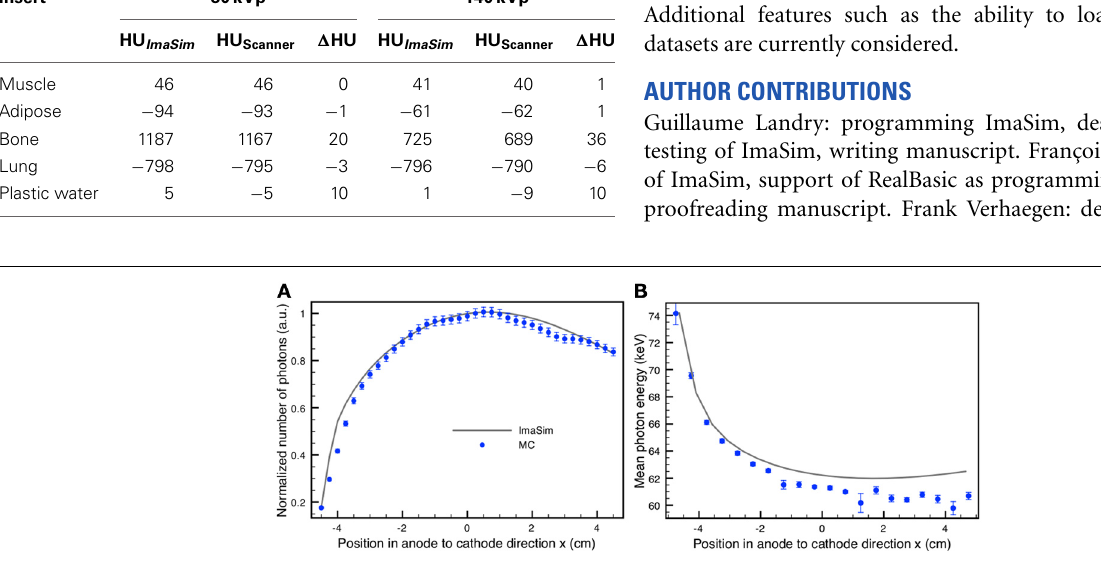
Table 2 | Comparison of HU from simulation and measurement. HU are ROI-averaged. Insert 80kVp 140kVp